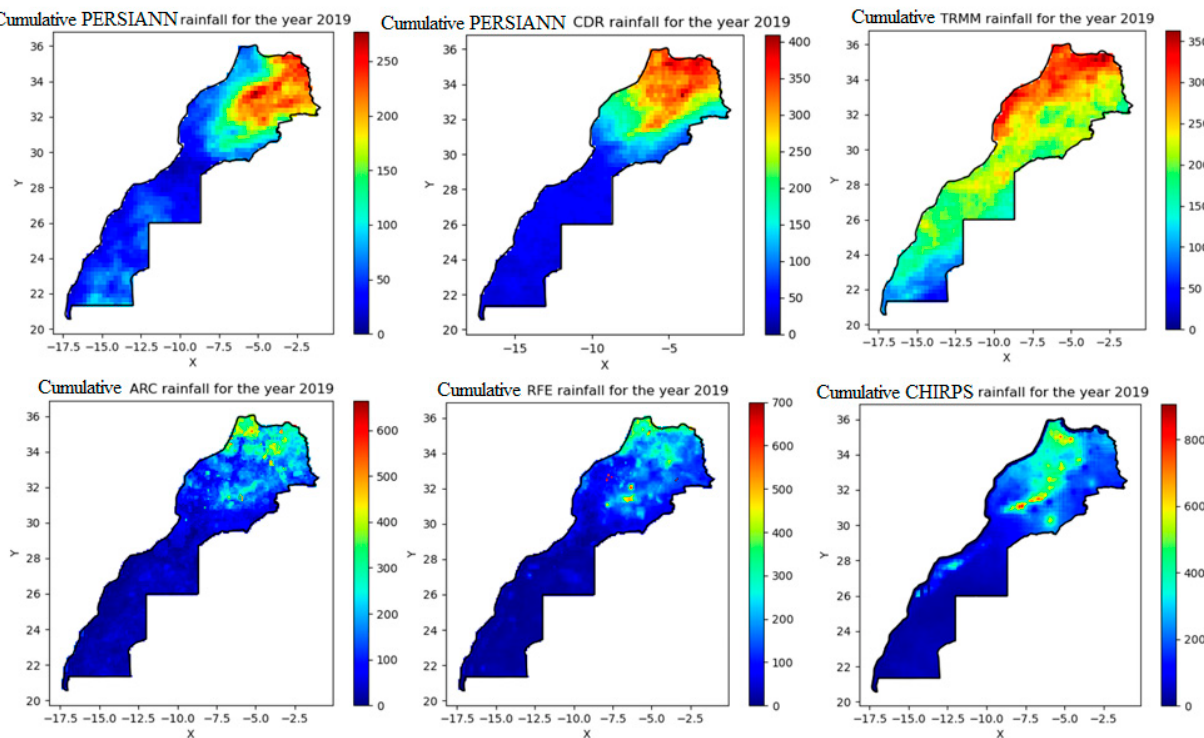
Figure 3. Simulated satellite-based cumulative rainfall for the year 2019.